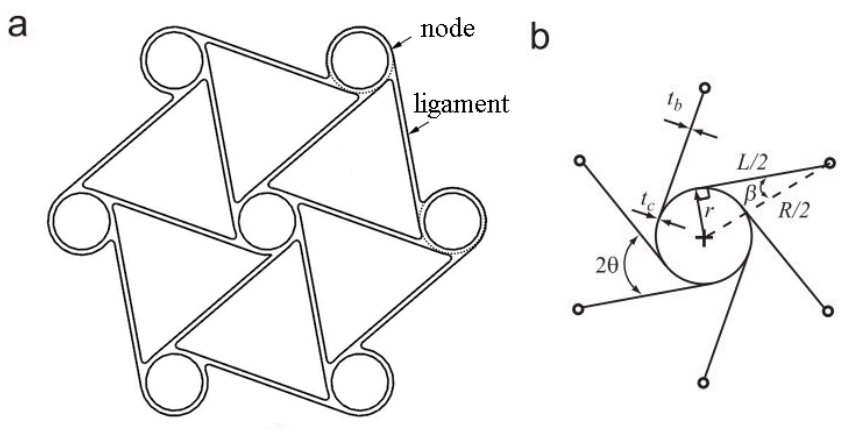
Figure 1. Hexagonal chiral element: ( a ) representative unit and ( b ) geometrical parameters. The angle of θ and β are the topology parameters, and their relationships between other parameters are given in Equation (1).